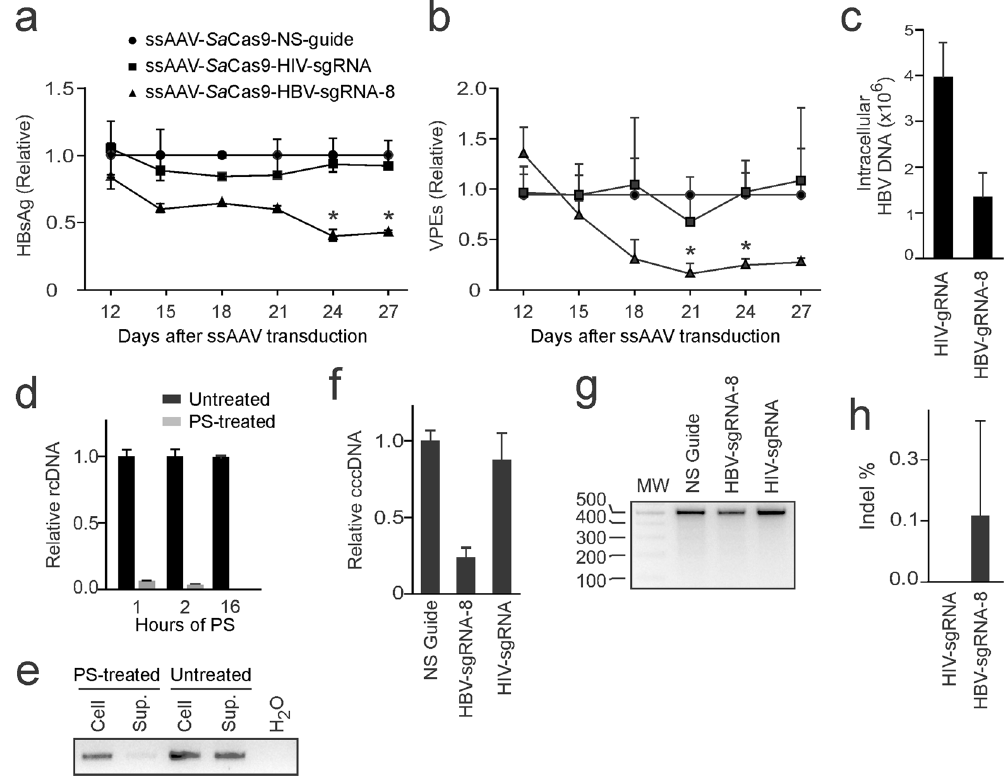
Figure 4. Evaluation of targeted mutation of cccDNA in HBV-infected hNTCP-HepG2 cells. Infection with HBV was carried out 24 hours prior to transduction of hNTCP-HepG2 cells with ssAAVs. Concentrations of ( a ) HBsAg and ( b ) viral particle equivalents (VPEs) in the culture supernatant were determined as described in Fig. 2b and c, respectively. Data are represented as the means and the error bars indicate standard deviation. Statistical differences are indicated by an asterisk ( * p < 0.05). ( c ) Intracellular HBV DNA was measured on day 27 after transduction of cells with the indicated ssAAVs. ( d ) DNA from culture supernatants of hNTCP-HepG2 cells was extracted with or without treating with plasmid-safe DNase for the indicated times and subjected to analysis using qPCR with primers specific for HBV DNA. ( e ) Representative agarose gel electrophoresis to detect HBV DNA from cell extracts and supernatants with or without treatment with plasmid-safe DNase. ( f ) Total DNA was extracted from HBV-infected hNTCP-HepG2 cells at day 27 after transduction with ssAAVs. cccDNA was quantified using qPCR and values are presented relative to the mean for the control non-specific guide RNA. Detection of indels in cccDNA using ( g ) T7E1 or ( h ) drop-off ddPCR TM assays. Comparisons were made using a two-tailed Student’s t-test, and significant statistical differences to the control samples treated with the non-specific guide are indicated ( * p <